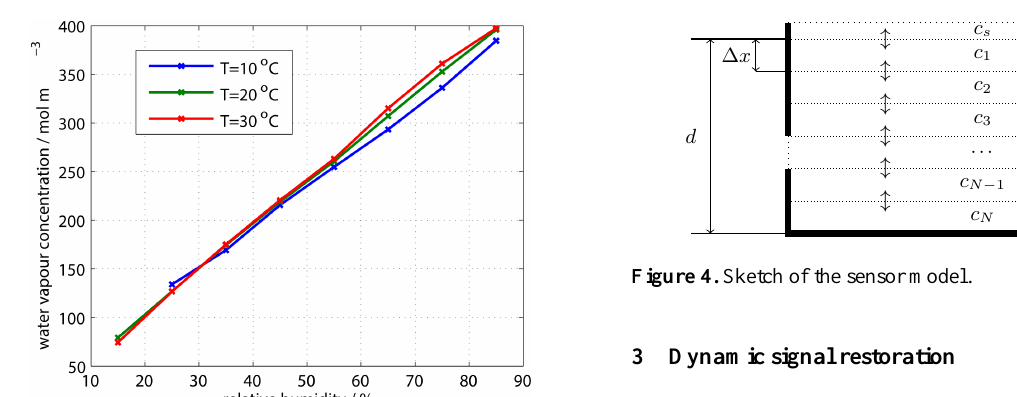
Fig. 5. Result of a step response experiment with rising edge (upper figures) and falling edge (lower figures) humidity in comparison to model results. The model was run with 40 layers and a diffusion coefficient D = 0 . 38 µm 2 s − 1 in all cases.